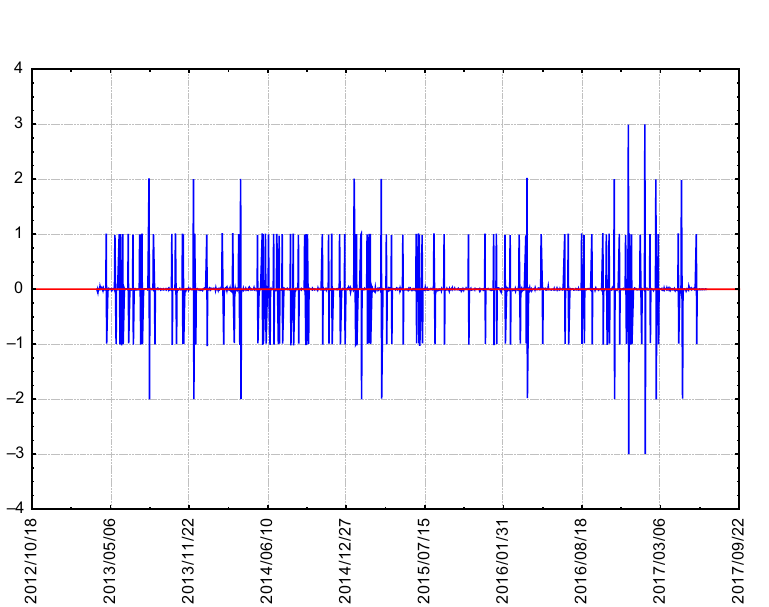
Figure 8. The conditional volatilities of the London gas oil futures in the presence of OPEC news over the period from April 01, 2013 to